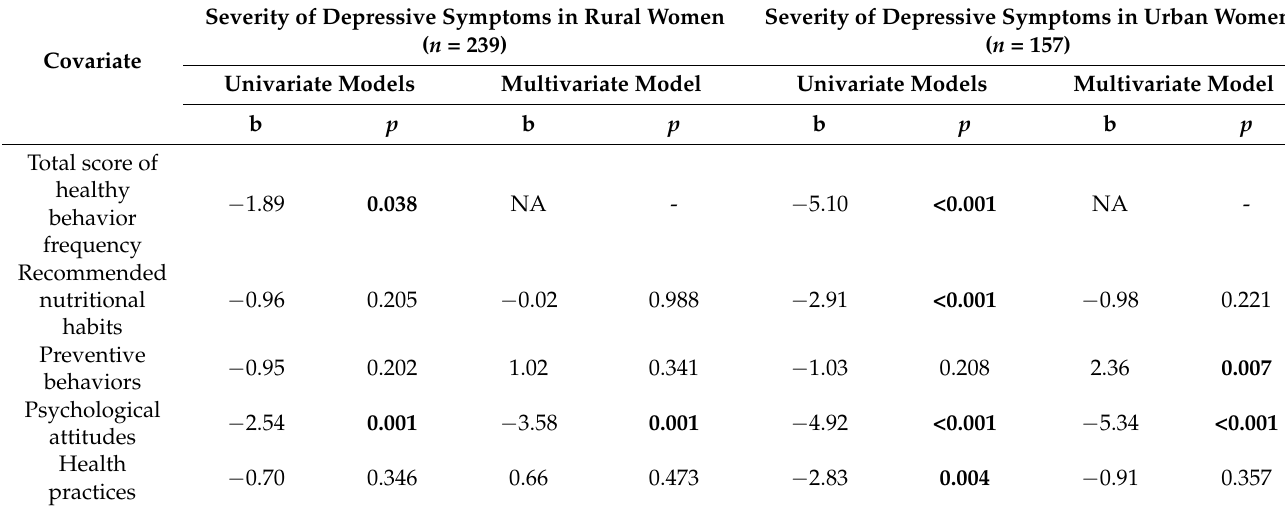
Table 6. Regression models of severity of depressive symptoms on healthy behavior frequency in study groups. Severity of Depressive Symptoms in Rural Women Severity of Depressive Symptoms in Urban Women ( n = 239) ( n = 157) Covariate Univariate Models Multivariate Model Univariate Models Multivariate